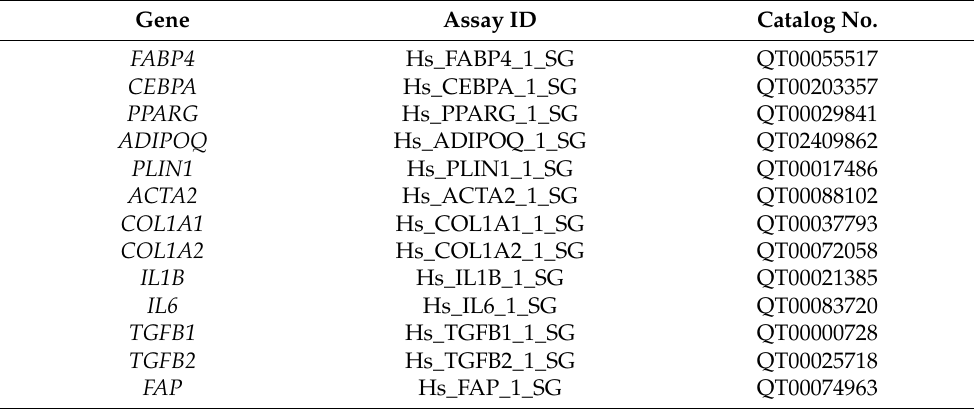
Table 1. Predesigned oligonucleotide primer pairs used for SYBR green real-time PCR.